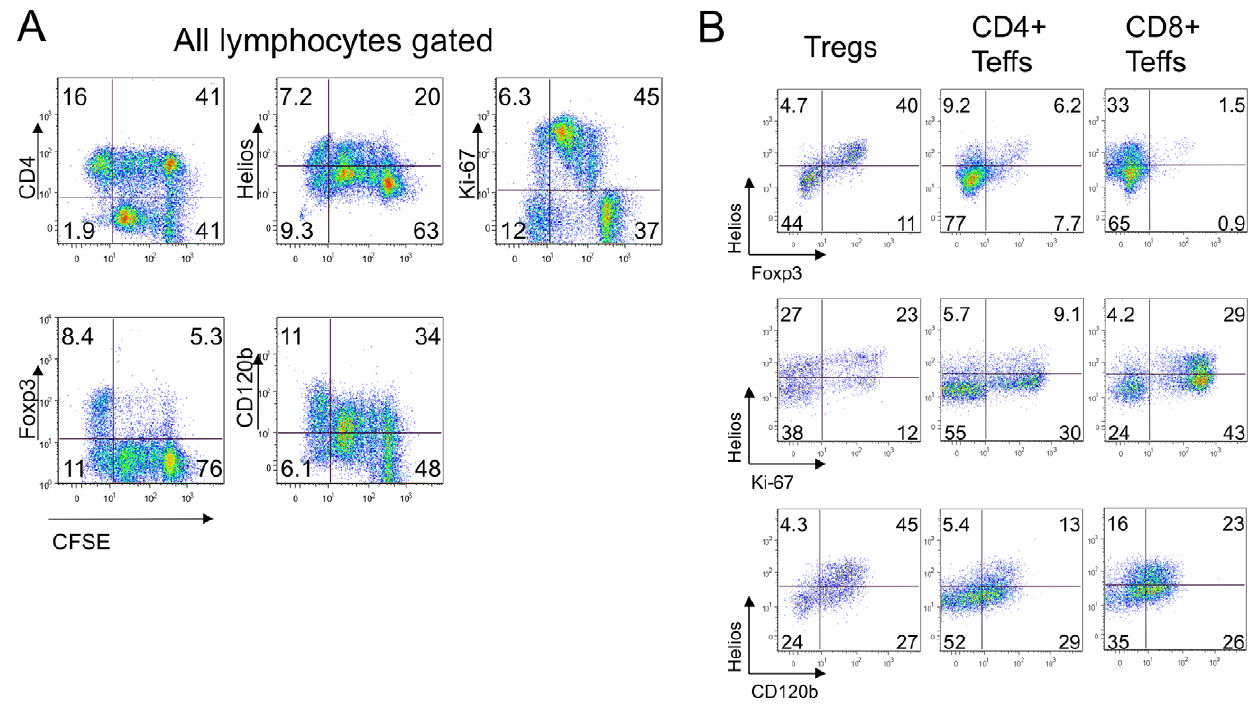
Figure 4. Helios expression in suppression assay is associated with cell activation and division. (A) After suppression assays, human Tregs and responders PBMC cells (1/2 Tregs/responders ratio) were stained for CD4, Helios, Ki-67, Foxp3 and CD120b; gating of live lymphocytes and co- expression of listed markers with CFSE divisions peaks shown, cells in CFSE-negative gate are Tregs. (B) Helios + Tregs but not CD4 + and CD8 + responders showed co-expression of Helios and Foxp3 (top row). Helios + cells showed more dividing (middle) and activated (bottom) phenotypes throughout all T cells subsets, including Tregs (left), CD4 + (middle) and CD8 + (right) cells. Data are representative of 2 experiments.